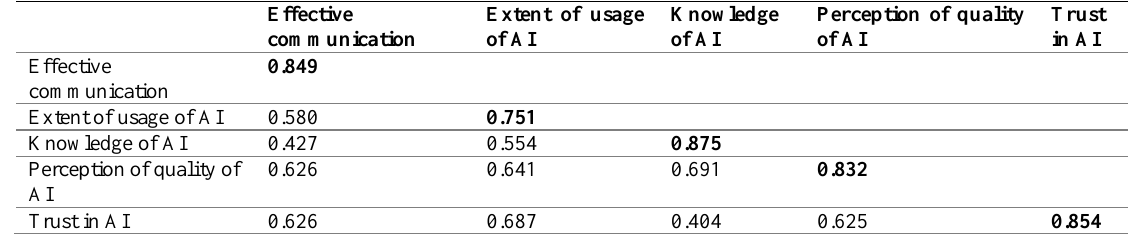
Table 4: Discriminant Validity-Farnell- LACKER